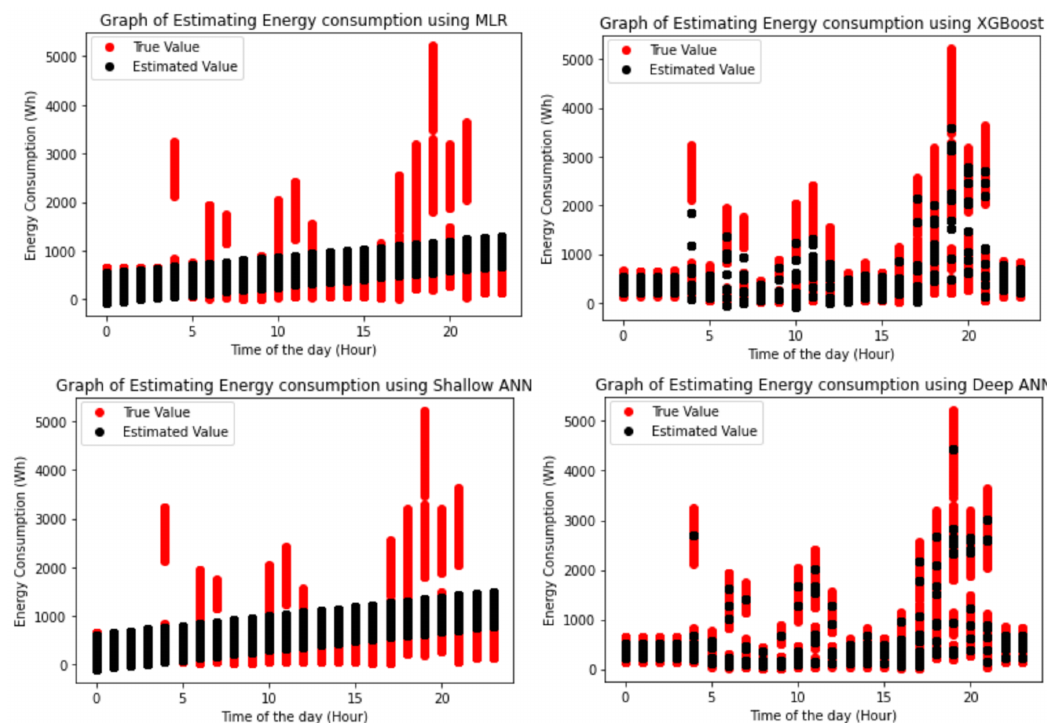
Figure 8. The graph shows the predication from each techniques: MLR ( top left ), XGB ( top right ), shallow ANN ( bottom left ), and deep ANN ( bottom right ).